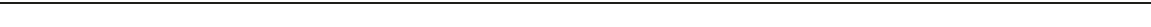
Fig. 3 Nfat2 deletion in CLL cells leads to signi fi cantly compromised survival of E µ -TCL1 mice. a Kaplan – Meier survival plot of TCL1 Nfat2 +/+ mice ( n = 10), TCL1 Nfat2 − / − mice ( n = 10) and Nfat2 +/+ ( n = 5) and Nfat2 − / − ( n = 5) controls. Statistical signi fi cance was determined using the Log-rank (Mantel – Cox) test, P = 0.0014. b Spleen size of representative animals of the indicated genotypes at an age of 36 weeks. c Average spleen weight of n = 5 animals with the indicated genotypes at an age of 36 weeks (Welch ’ s t -test, Mean ± S.E.M., *** P < 0.005, not signi fi cant (n.s.)). d Accumulation of CD19 + CD5 + B cells in the spleen, lymph nodes and bone marrow of one representative Nfat2 +/+ , TCL1 Nfat2 +/+ and TCL1 Nfat2 − / − mouse at an age of 28 weeks assessed by fl ow cytometry. e – g Accumulation of CD19 + CD5 + B cells in the spleen, lymph nodes and bone marrow of TCL1 Nfat2 +/+ mice, TCL1 Nfat2 − / − and Nfat2 +/+ mice ( n = 5 per group) assessed by fl ow cytometry at an age of 28 weeks (Welch ’ s t -test, mean ± S.E.M., * P < 0.05). h ZAP70 and CD38 expression on CD19 + CD5 + B cells from animals with the indicated genotypes at an age of 28 weeks. n = 5 animals per group were analysed by fl ow cytometry (Welch ’ s t -test, Mean ± S.E.M., *** P < 0.005). i Expansion of CD19 + CD5 + CLL cells in the peripheral blood of NSG mice transplanted with CLL cells from TCL1 Nfat2 +/+ ( n = 5) or TCL1 Nfat2 − / − mice ( n = 6) assessed by fl ow cytometry at the indicated time points (Student ’ s t -test, mean ± S.E.M., p = 0,0134). j Kaplan – Meier survival plot of NSG mice transplanted with CLL cells of the indicated genotype. Statistical signi fi cance was determined using the Log-rank (Mantel – Cox) test, P =